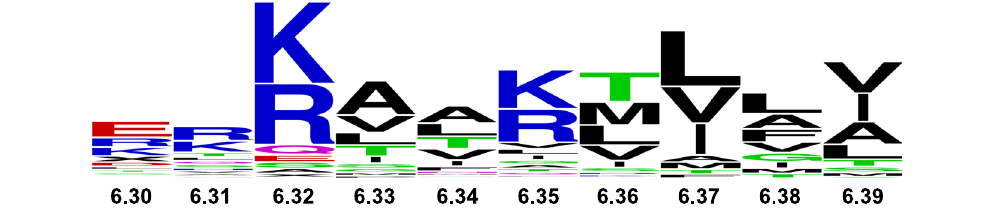
Fig. 7 | Conservation of residues at the intracellular end of helix 6 among 290 class A GPCRs. The size of each one-letter amino acid corresponds to the fre- quency of occurrence for that amino acid type. Numbers indicate the residue